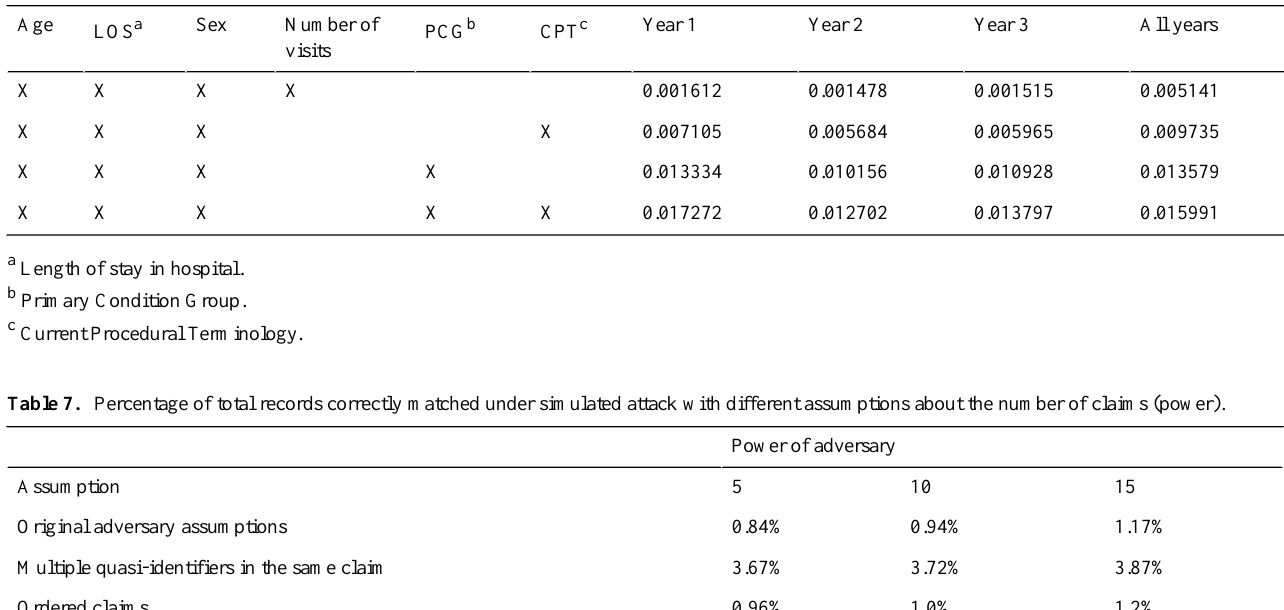
Table 6. Estimated proportion of all records in the Heritage Health Prize dataset that would be correctly matched against the State Inpatient Database.